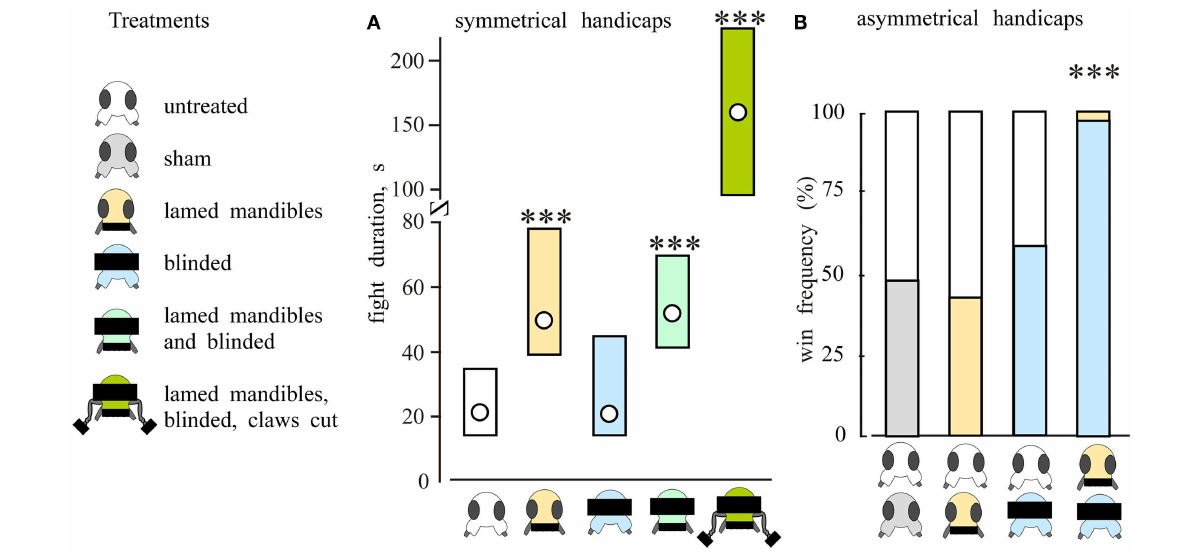
FIGURE 6 | Handicaps reveals assessment strategy in crickets. (A) Symmetrical handicaps. Bars giving the level of aggression (median, interquartile range) for fights between pairs of crickets that were both (from left to right) untreated (n = 38), had lamed mandibles (n = 26), blinded (n = 19), had lamed mandibles and blinded (n = 26) or lamed mandibles, blinded, and clipped foreleg claws (n = 23). (B) Asymmetrical handicaps. Bars giving the